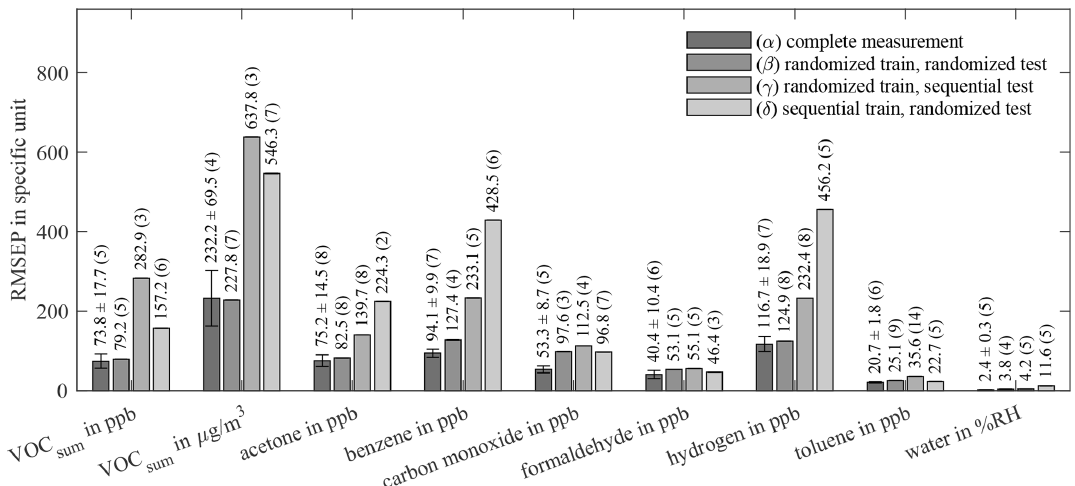
Figure C1. Root-mean-square error of prediction (RMSEP) of AS-MLV for different training and testing models and targets. All models use 10-fold cross-validation for hyperparameter optimization; the resulting number of PLSR components, determined with Eq. (2), is given in parentheses. A detailed description of ( α )–( δ ) is given in Table 4.